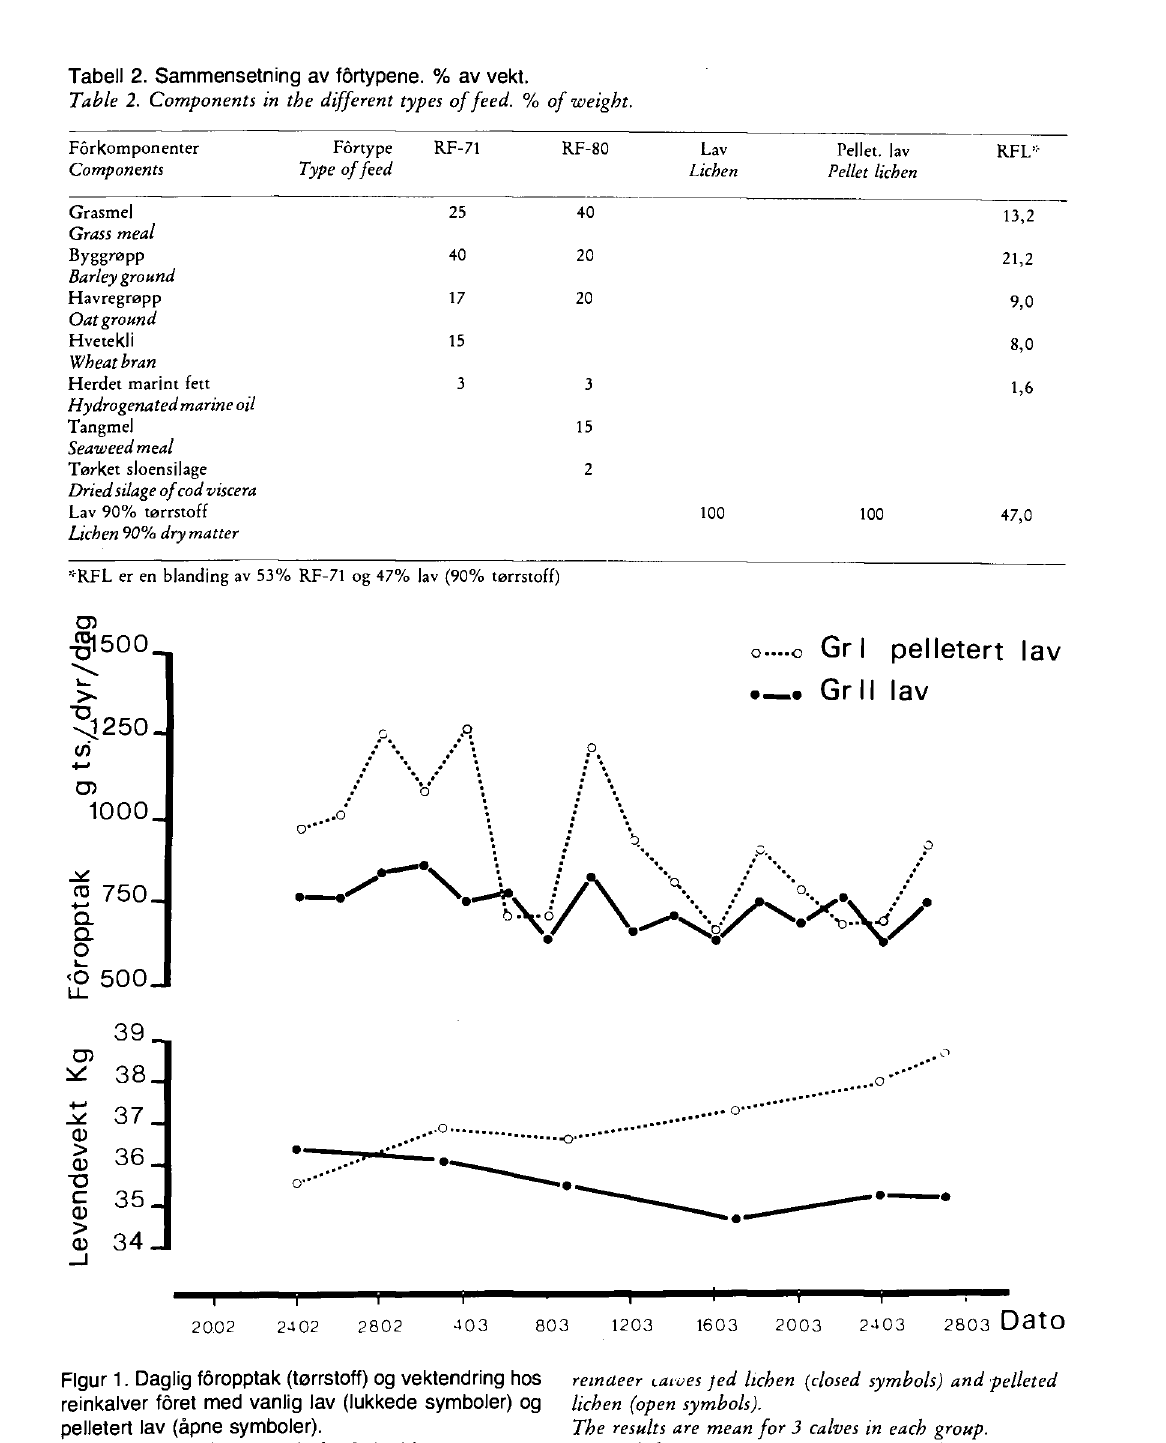
reindeer caiues Jed lichen (closed symbols) and pelleted lichen (open symbols). The results are mean for 3 calves in each group. Lav = lichen. Levende vekt = Live weight. Foropptak = Feed intake. Dyr = Animal. Dag =